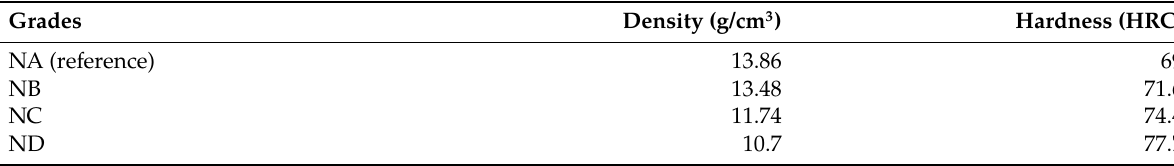
Table 2: Density and hardness of cermets. Grades